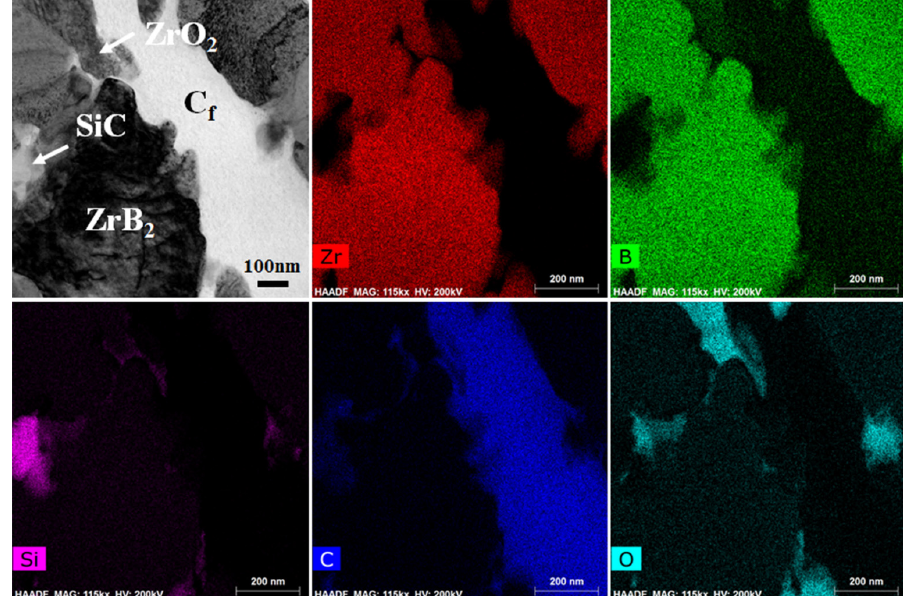
Fig. 4 Bright field image and element distribution on the observed area of ZSC30 performed by TEM showing phases